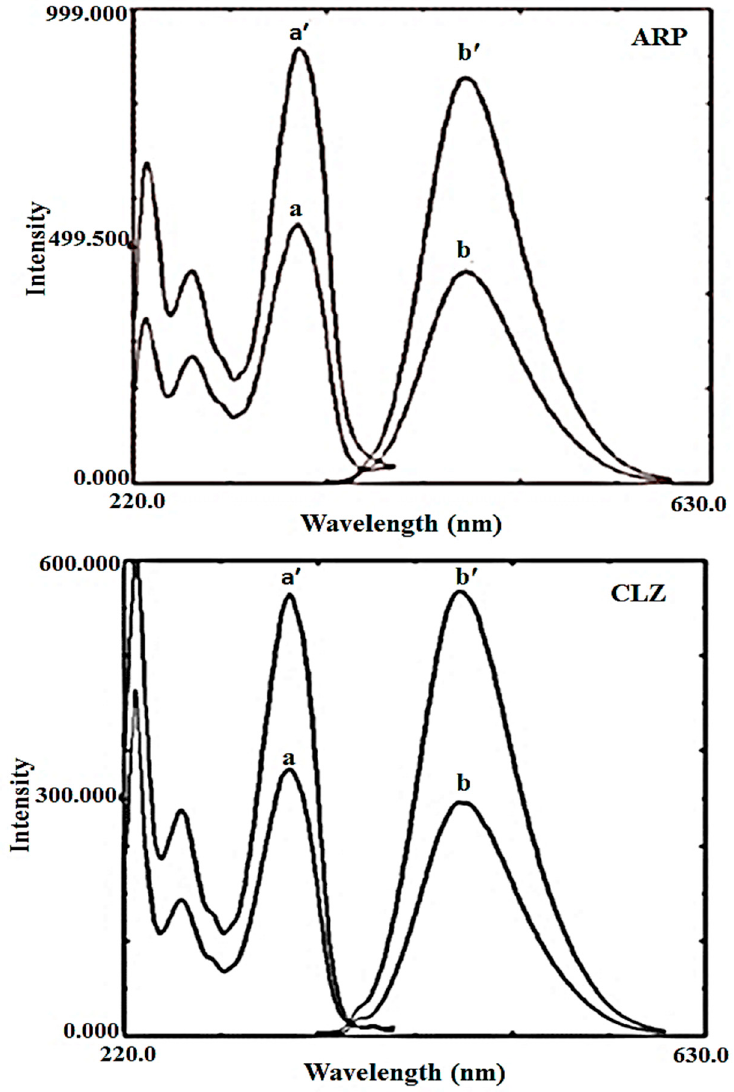
Figure 1. Excitation (a, b) and emission spectra (a ′ , b ′ ) for the blank of o -phthalaldehyde and sample (reaction product of ARP and CLZ with o -phthalaldehyde in borate buffer), respectively.